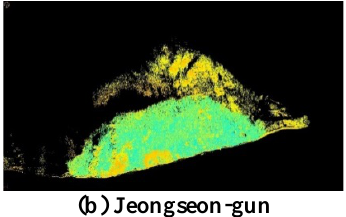
Figure 4. Scanning point cloud data of the steep slopes